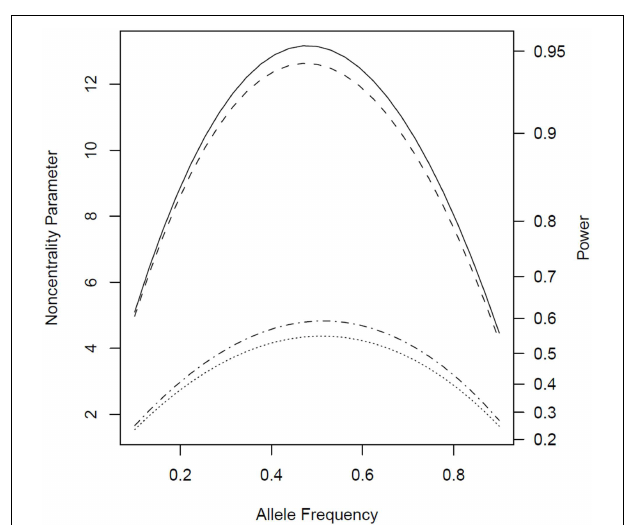
FIGURE 5 | Noncentrality parameter and power as a function of allele frequency under scenarios where both parents can be affected. All designs used 300 complete triads in a homogenous population under the risk scenario: R 1 = R m 1 = 1 . 4 , R 2 = R m 2 = 1 . 96 , and S 1 = S 2 = 1 . The baseline risk in mothers of affected offspring is 0.2 and 0.1 in fathers of affected offspring. Vertical axes: left, the chi-squared noncentrality parameter for a 1-df likelihood ratio test; right, power at α = 0 . 05 . Horizontal axis shows the allele frequency ranging from 0.1 to 0.9. Curves: dot, parenTDT ; dash-dot, Parent ; dash, combTD T; solid, PPI-CT